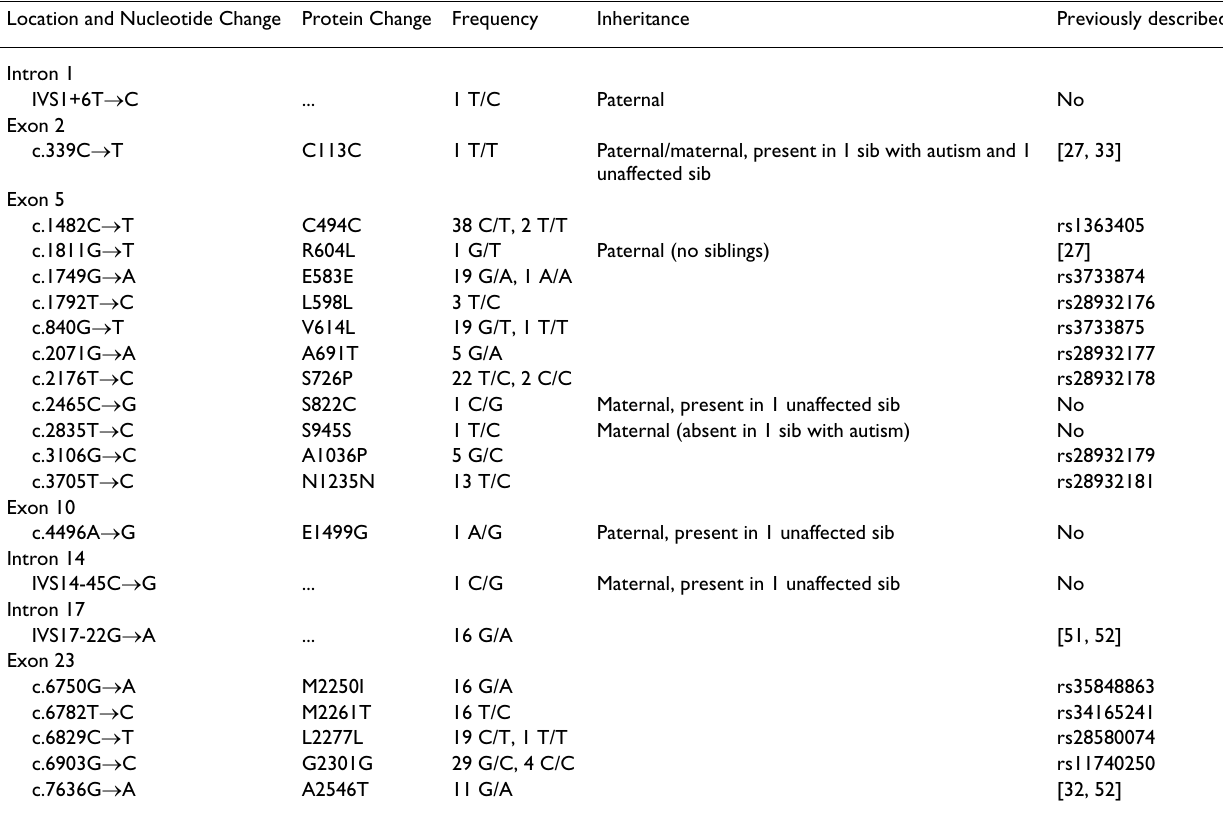
Table 1: Sequence variants identified in the NSD1 gene in 88 patients with autism spectrum disorders and macrocephaly Location and Nucleotide Change Protein Change